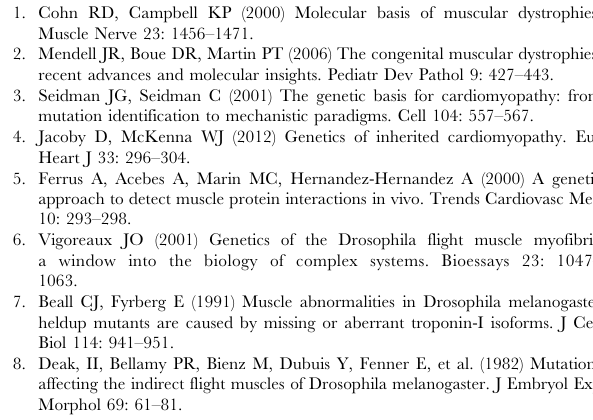
tal stage at the indicated time points. Pupae present at day 11 do not progress to adulthood. Figure S2 Differences in the levels of PINCH transgene expression are post-transcriptional. RT-PCR from adult fly lysates shows that mRNA levels transcribed from the wild type, Q38A and D303V versions of the PINCH transgene are identical. GAPDH is used as a loading control. Figure S3 Expression of wild type or PINCH mutant transgenes alone does not significantly affect larval motility. The average percentage of larvae located in each zone at the end of the larval motility assay is plotted for the indicated genotypes. Figure S4 Expression of Zasp-GFP in the flw 7 genetic background does not significantly alter viability or motility in four-day-old larvae. A) The graph shows the percentage of flw 7 ; Zasp-GFP animals of the given developmental stage at the indicated time points. Expression of Zasp-GFP in the flw 7 mutant prevents pupariation, but at the time at which VIS muscle integrity is assessed (indicated by arrow), larval viability is not compromised (compare to Figure 2B), and B) motility is unaffected. The average percentage of larvae located in each zone at the end of the motility assay is plotted for the indicated genotypes. Figure S5 Expression of wild type or mutant PINCH transgenes does not significantly affect VIS muscle attachment. The graph shows the percent of total animals in which the VIS muscles exhibit detachment. Number of animals examined of each genotype is shown above the bars.